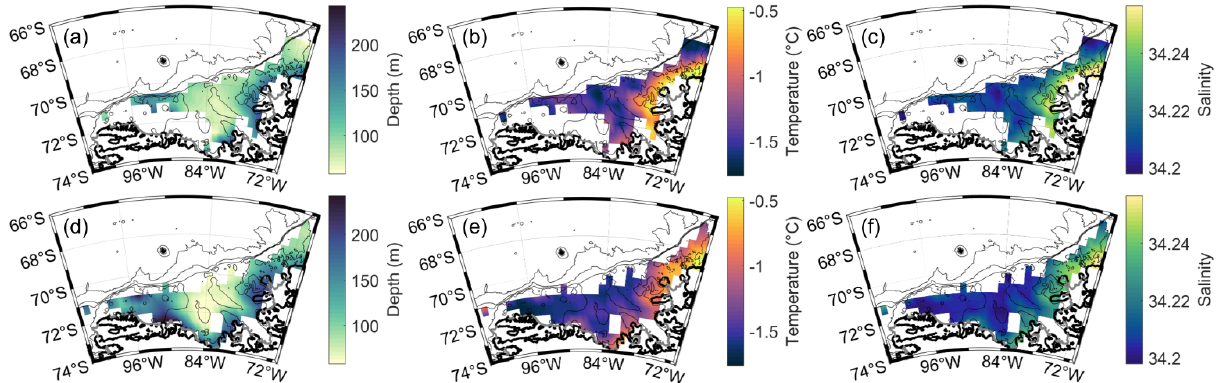
Figure A2. The distribution of properties on the WW potential density layer ( σ 0 = 27 . 4kgm − 3 ), divided into (a–c) winter (April–September) and (d–f) summer (October–March) months. (a, d) Depth of the density layer (meters), (b, e) potential temperature (degrees Celsius), and (c, f) salinity are shown.